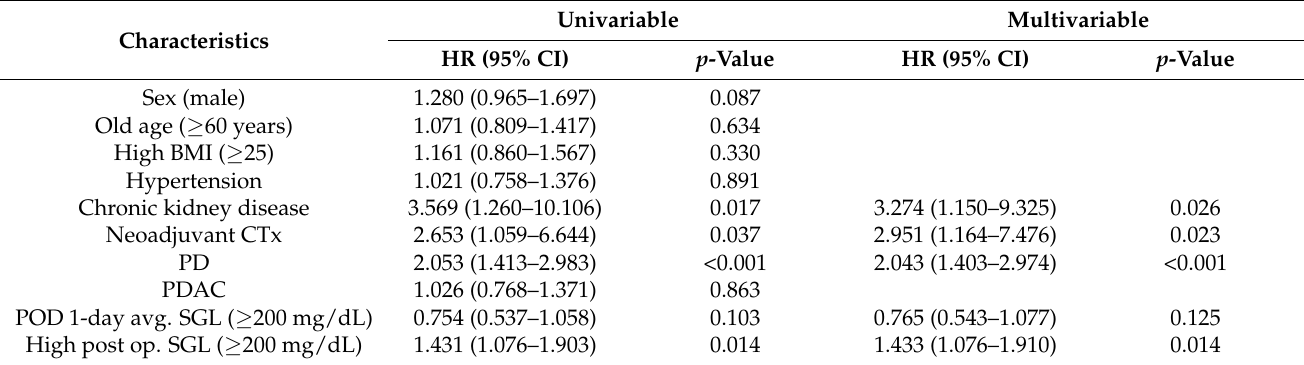
Table 5. Logistic regression for risk factor analysis of